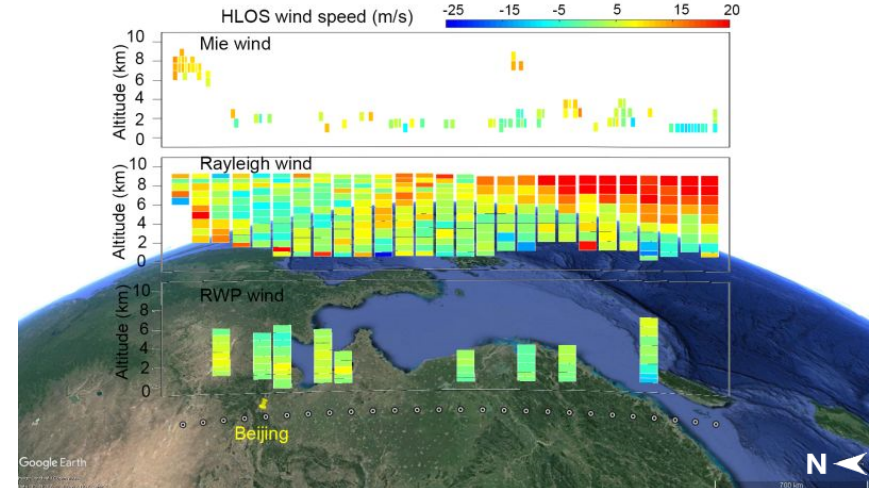
Figure 3. Case study of HLOS wind component profiles on 28 April 2020 between 21.5 and 43.5 ◦ N superimposed on the Google Earth map of east China (© Google Maps). The top, middle, and bottom panels show Mie-cloudy, Rayleigh-clear, and RWP wind profiles, respectively. The color bar represents the HLOS wind vector component in meters per second.